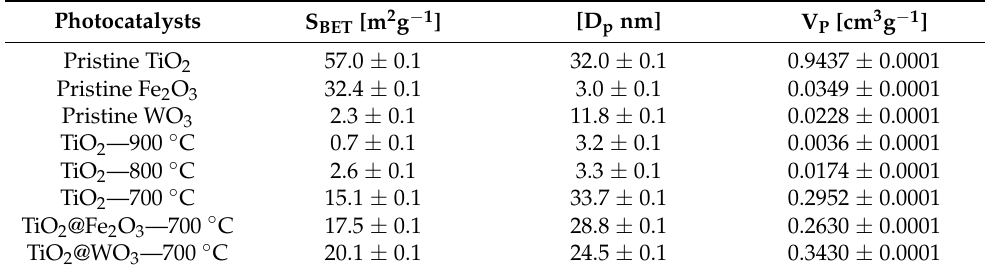
Table 1. Textural properties of exanimated samples.